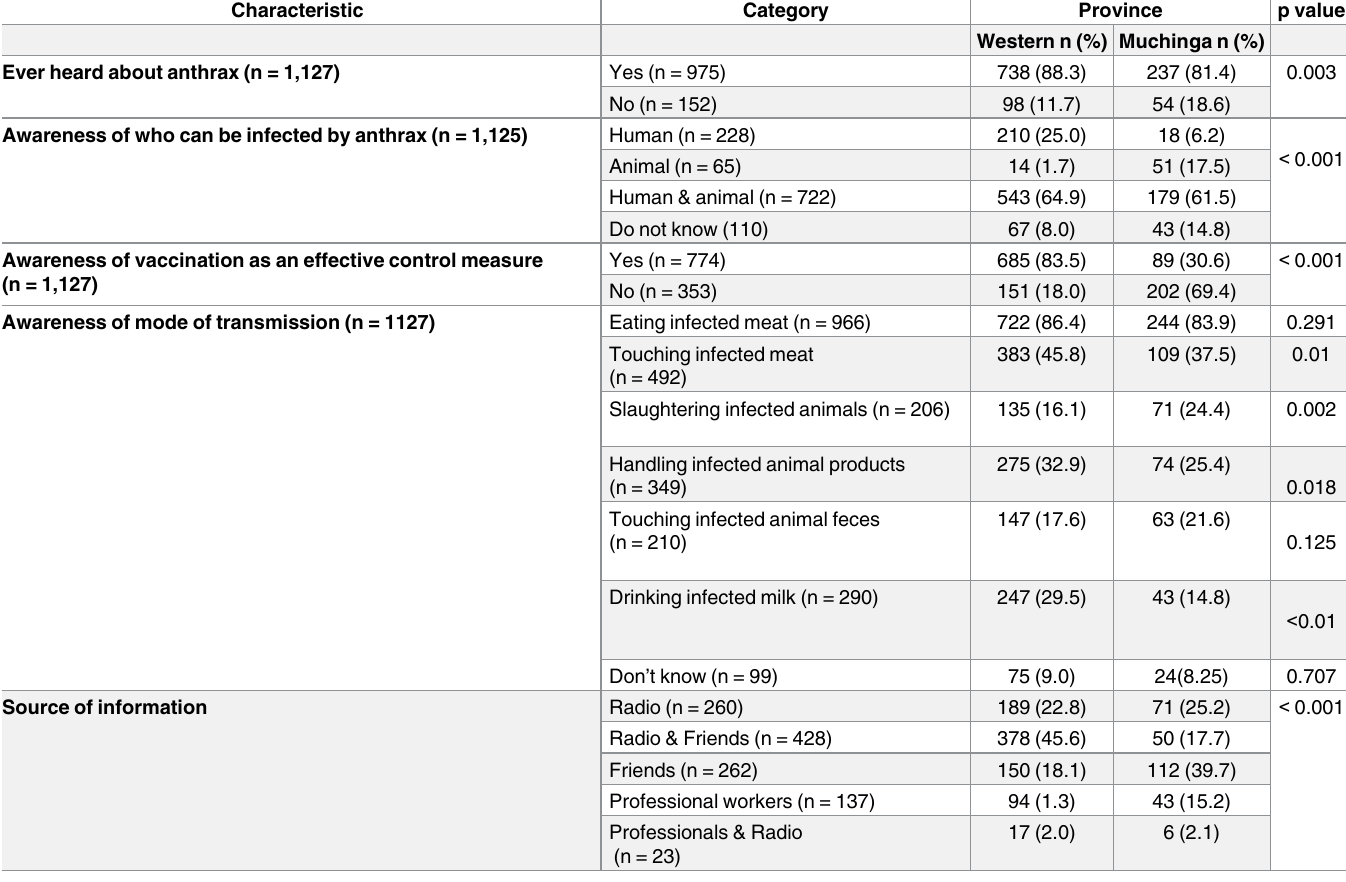
Table 2. Comparison of awareness of anthrax among respondents in 2 provinces, given as numbers (%).